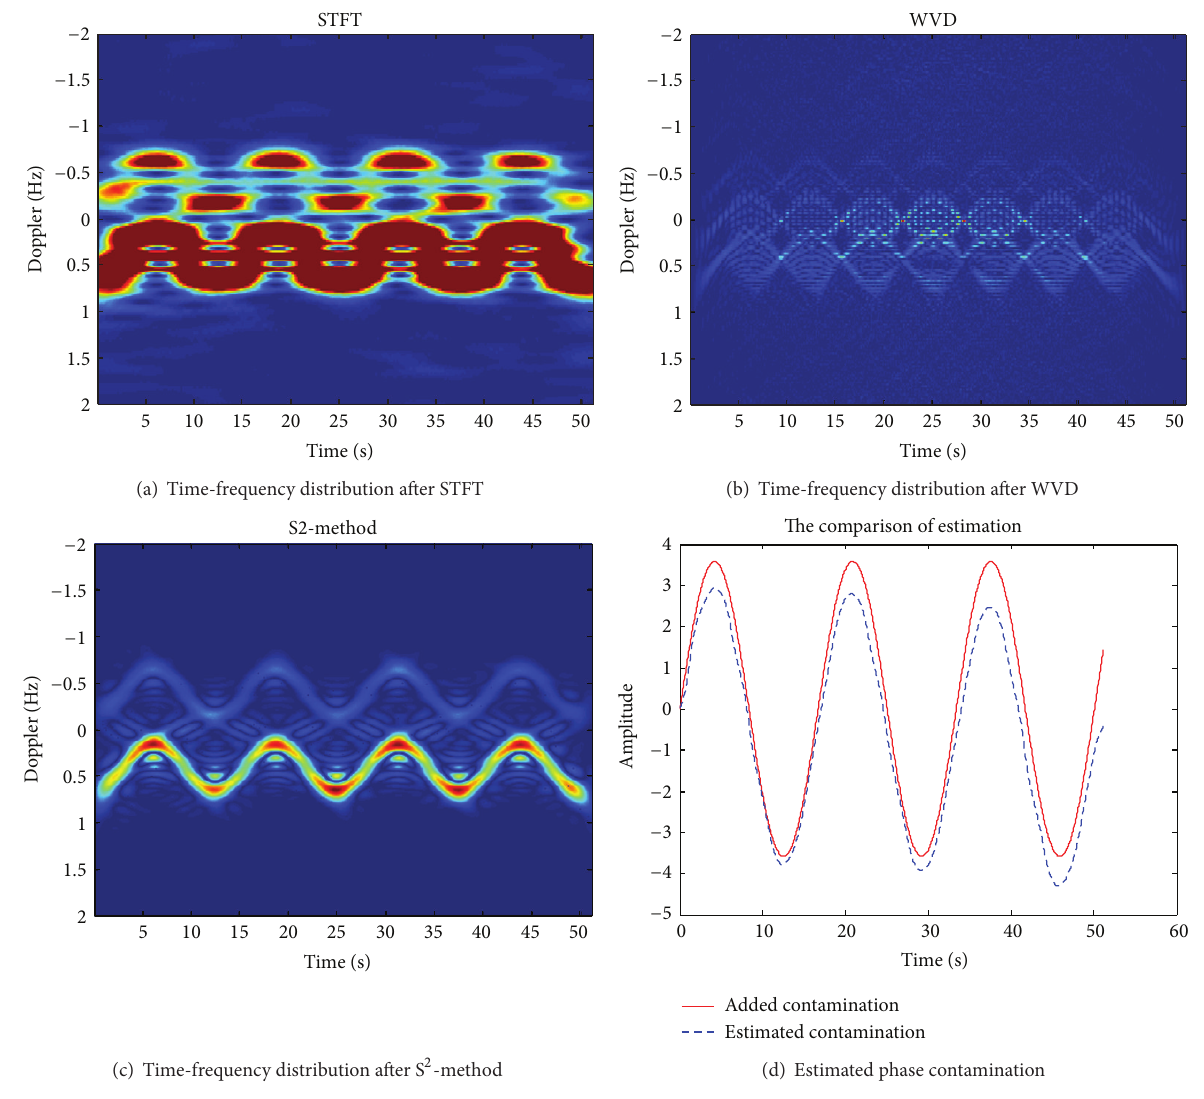
Figure 4: The time-frequency distribution of the contaminated sea clutter with large amplitude contamination after STFT, WVD, and S 2 -